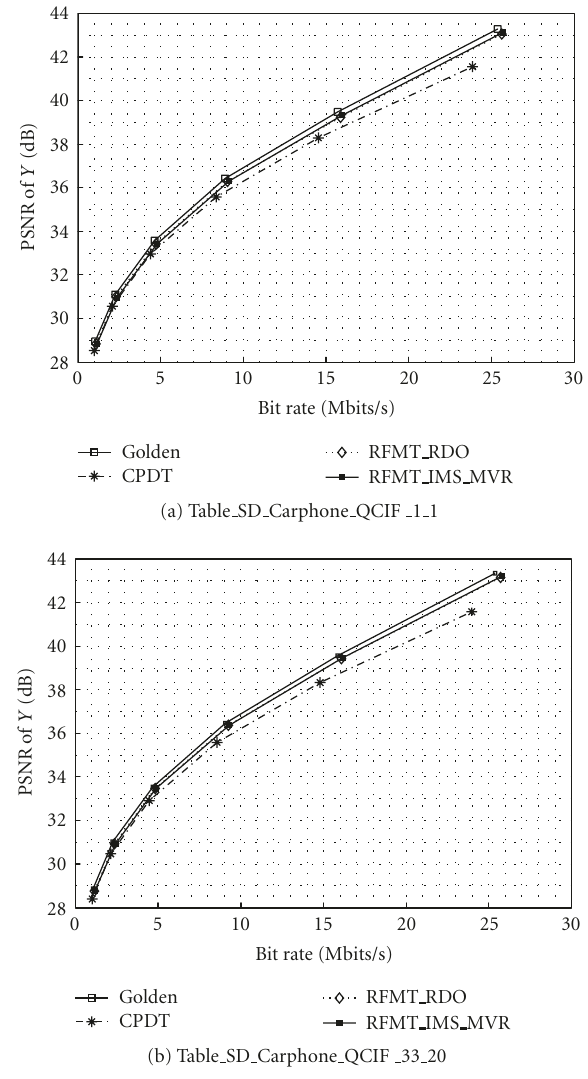
Figure 12: Rate-distortion performance of the luminance compo- nent by one foreground embedding for Table SD Carphone